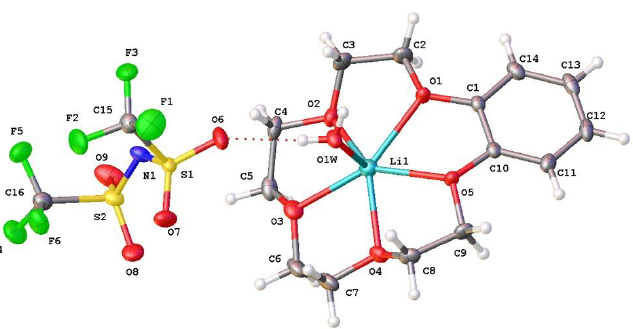
Figure 5. Structure of formula units in crystal ( I ). Ellipsoids of l.s. temperature atomic displacements are shown at 50% probability level. The crystal consisted of NTf 2 − anions and lithium cations coordinated by five oxygen atoms of the B15C5 and the water molecule in the apical position of the pentagonal pyra- mide. The lithium atom was displaced from the basis plane by 0.28 Å ; the displacements of the crown ether oxygen atoms from their mean plane varied within the range of 0.06 – 0.19 Å. In the coordination polyhedron, the Li…O1w with the water oxygen was the short- est one (Li…O1w 1.919(2) Å). The distances between the crown ether oxygen atoms were much longer. The Li…O distances with the O1 and O5 atoms in the sp 2 hybridization state (angles C-O-C 117.14(9) and 117.39(9)°) were longer (2.278 and 2.269 Å ) than those with the О2, О3, and О4 atoms in the sp 3 hybridization state, which were equal to 2.197(2), 2.206(2), and 2.218(2) Å , respectively. The angles at the О2, О3, and О4 atoms varied within the range of 112.7° – 114.1°. Since the atom in the sp 3 hybridization state had a bigger covalent radius than that of the atom in the sp 2 hybridization state, one should expect an opposite Li…O(sp 3 ) to Li…O(sp 2 ) ratio. This discrepancy was apparently due to the higher conformational rigidity of the fragment of the macrocycle involving the O1 and O5 atoms, the last ones being involved in a conjugation with the benzene ring. A similar peculiarity was also observed in the earlier-studied structures of lithium with B15C5 and water in the apical position of lithium coordination polyhedron and various counterions (Cl − , I − , ClO 4 − , NO 3 − , BF 4 − ) [22]. In this study, a rather complicated NTf 2 − anion was used. In contrast to simple inorganic anions, anion A is therefore able to coordinate the metal atom to compete with B15C5 for lithium coordination. This anion may coordinate with lithium in several ways. One of these is bridging the function of the ligand through oxygens of different SO 2 fragments: Li 1 …[O 1 =S(O)CF 3 -N- (CF 3 (O)S=O 2 ]…Li 2 . One other way is using a chelate coordination, when the same oxygen atoms are coordinated with the same lithium atom Li 1 …[O 1 =S(O)CF 3 -N-(CF 3 (O)S=O 2 ]…Li 1 [23 – 26]. There have also been known cases of the ligand monodentate coordination [23]. However, cases demonstrating the mixed chelate-bridging function of the NTf 2 − anion in lithium complexes are more widespread [27 – 29]. Cases of separated cations and anions are also available [30]. Lastly, the theoretical variant of an interaction of the cation with the anion nitrogen atom bearing a negative charge should also be taken into account. The structures of these types are not available for lithium in the Cambridge Structural Data- base. However, in principle, such a possibility cannot be excluded, and this coordination was actually observed for Cs [31]. In structure (I) , there were no direct interactions between the lithium atoms and the anions, but cations and anions were linked in infinite chains through hydrogen bonds O- H…O between coordinated water molecules and SO 2 fragments of the anions (Figure 6).